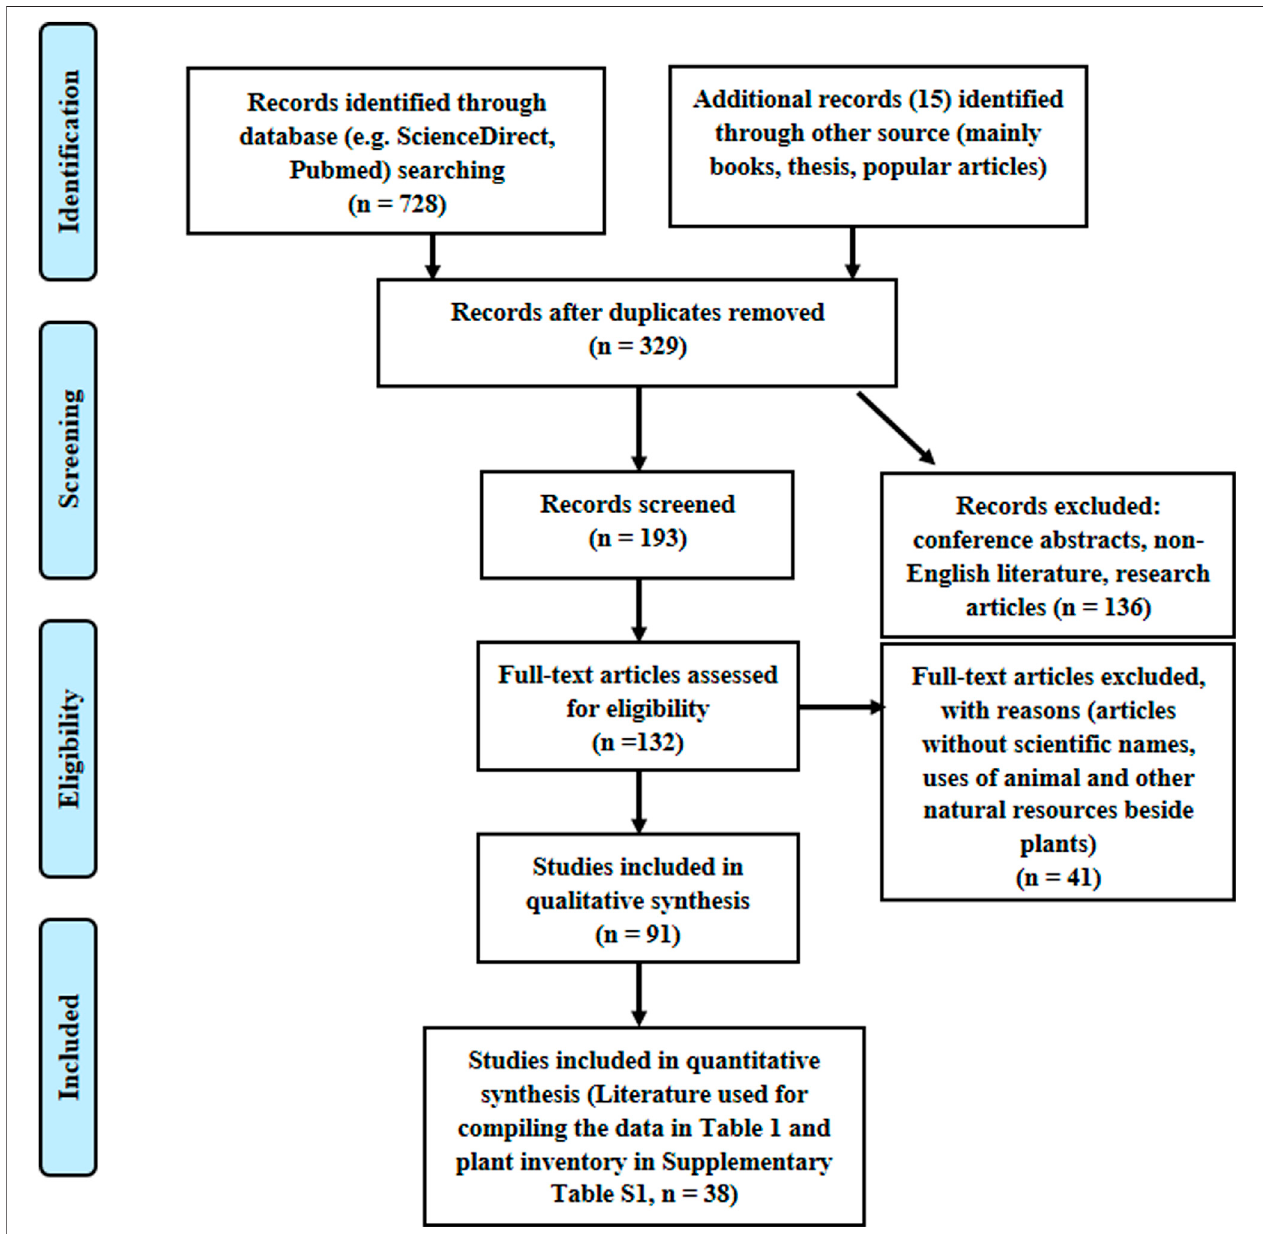
FIGURE 1 | Flow diagram for selection of articles/books/theses included in the systematic literature review for compiling data in Table 1 and Supplementary Table S1 .